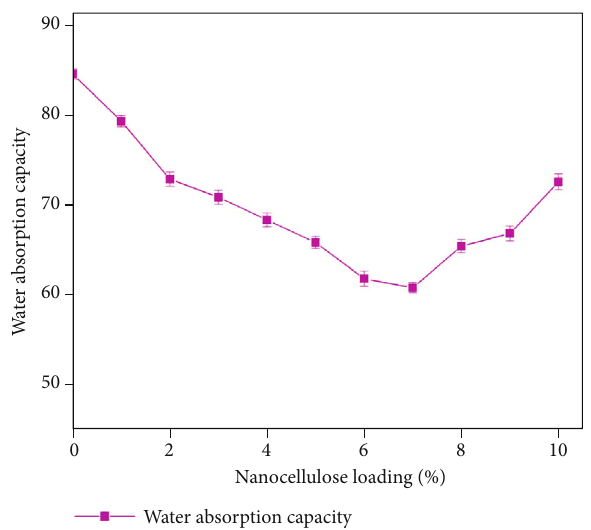
Figure 3: Water absorption capacity of PVA-NC composite fi lms at various amounts of nanocellulose loading.